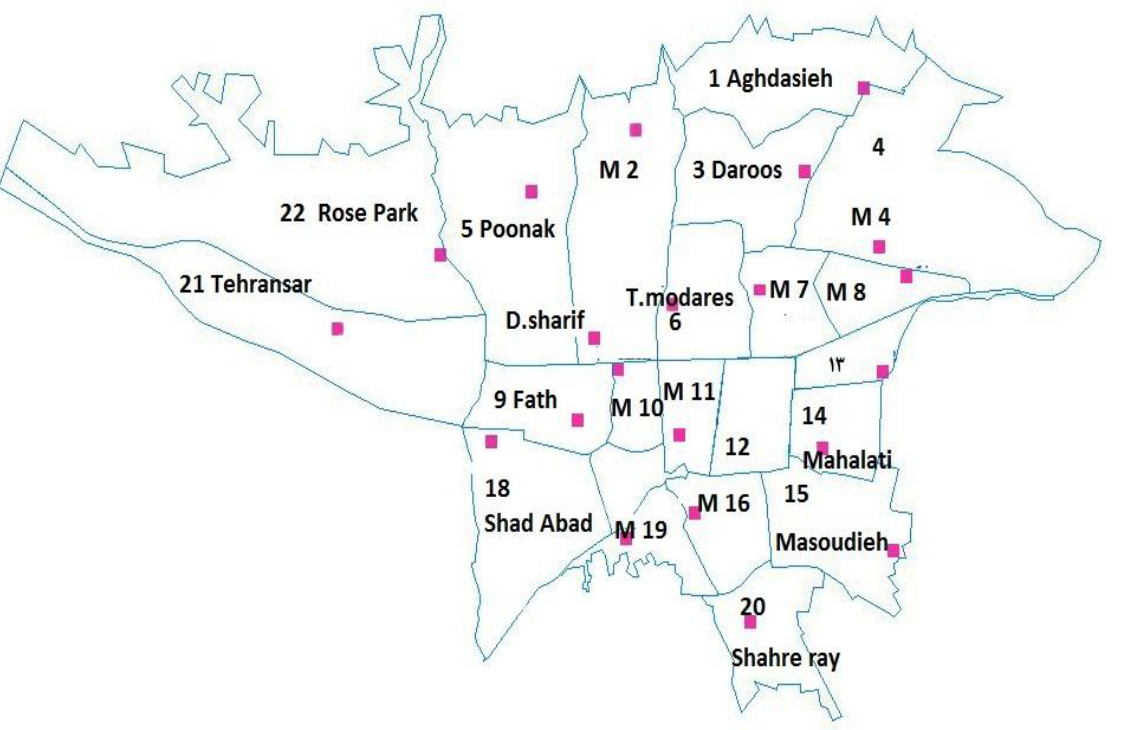
Figure1. Map of the study area including air quality monitoring